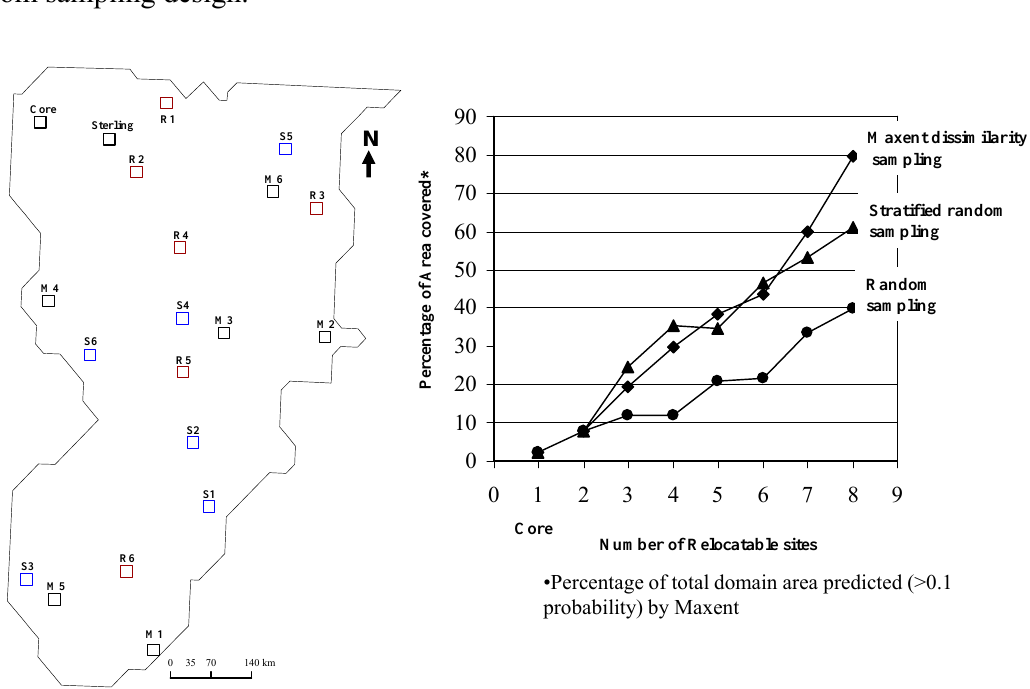
Figure 4. Number of sample sites (each 20 × 20 km area) and percent of regional environmental envelop captured by the Maxent dissimilarity sampling design (diamonds), stratified random design (triangles), and simple random design (circles). The Core site and Sterling site are held constant for all designs. M1 to M6 are the sites selected using Maxent Dissimilarity Sampling, S1 to S6 using stratified random sampling, and R1 to R6 using random sampling